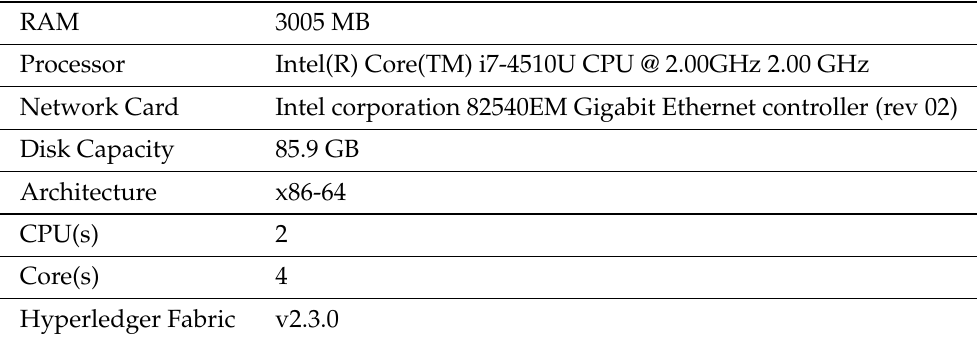
Table 6. Testbed